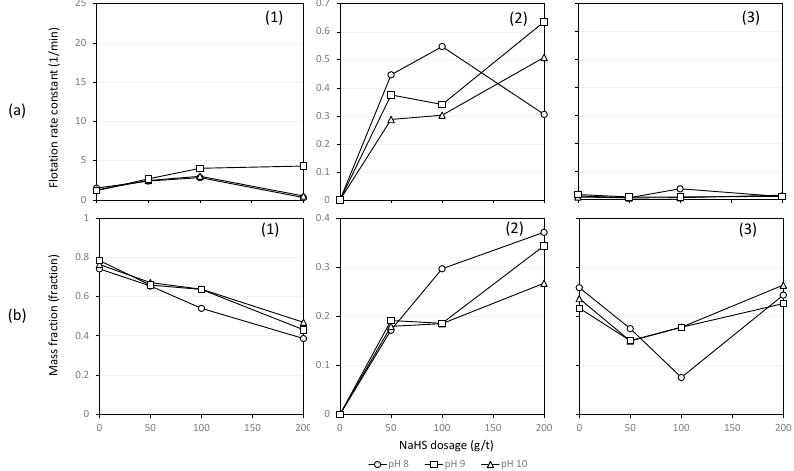
Figure 11. The bornite results of ( a ) flotation rate constants, (1) K 1 , (2) K 2 , (3) K 3 , and ( b ) mass fraction, (1) φ 1 , (2) φ 2 , (3) φ 3 , without NaHS and with NaHS dosages of 50 g/t, 100 g/t, and 200 g/t at pH 8, 9, and 10.